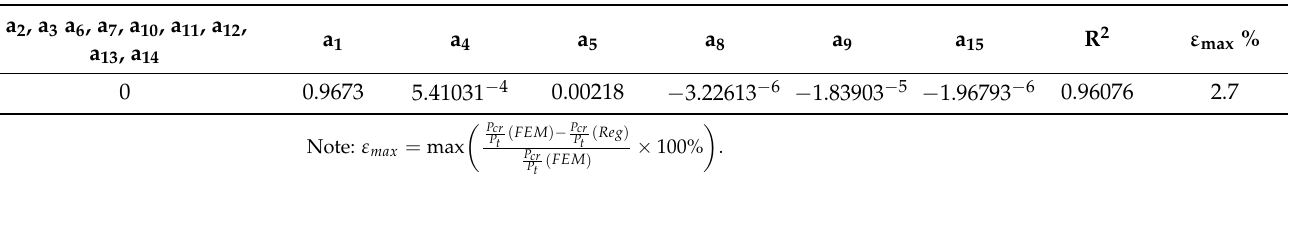
Table 7. Regression formula coefficients for cracked cylindrical shell with Clamped on both ends ( L / R = 20, R / T =